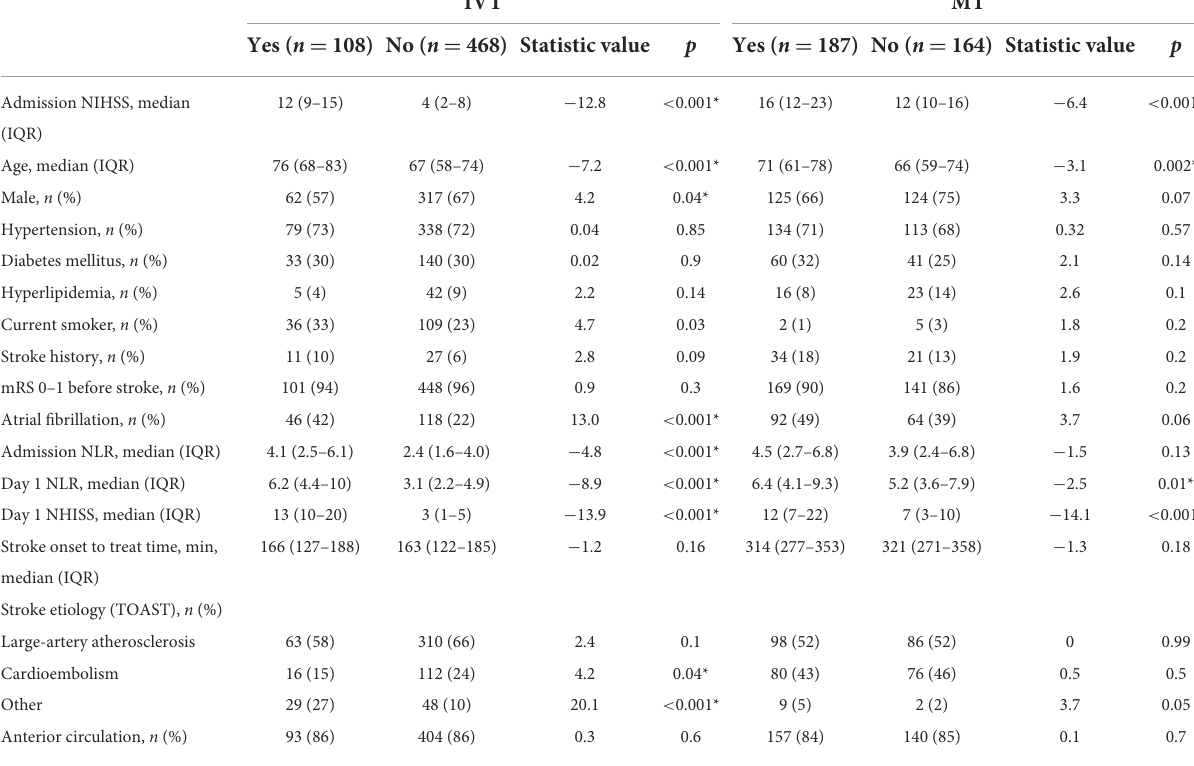
TABLE 2 Comparison of clinical characteristics and NLR in patients presented with dependence or not at 90